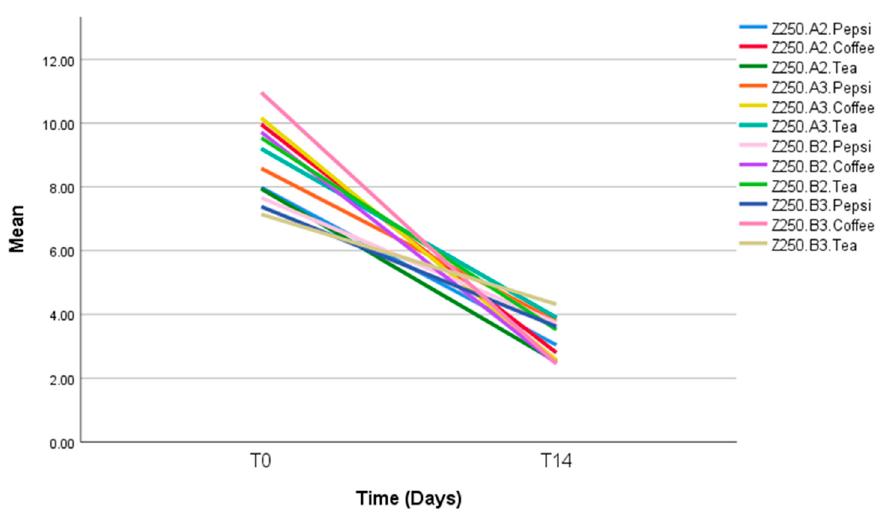
Figure 5. Graphical representation of mean changes in color ( ∆ E) value of Filtek Z250 composite from T0 (Day 0) to T14 (Day 14).